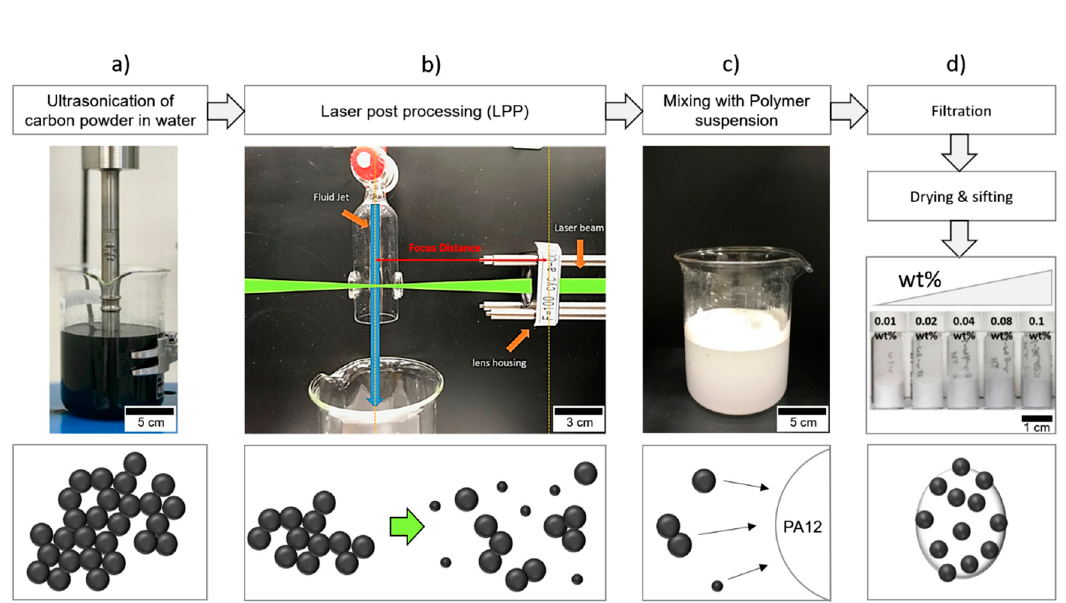
Figure 1. Process chain for colloidal additivation of PA12 micropowder with carbon nanoparticles: ( a ) Dispersion of aggregated carbon nanoparticle powder in water by ultrasonication. ( b ) Laser postprocessing (LPP) with a high power, high repletion rate laser, focused on the nanoparticle dispersion in a liquid jet. ( c ) Cixing of the irradiated colloid with the polymer powder and adsorption of nanoparticles on the polymer particles. ( d ) Filtration, drying, and sifting to yield dry nanofunctionalized PA12 powder.